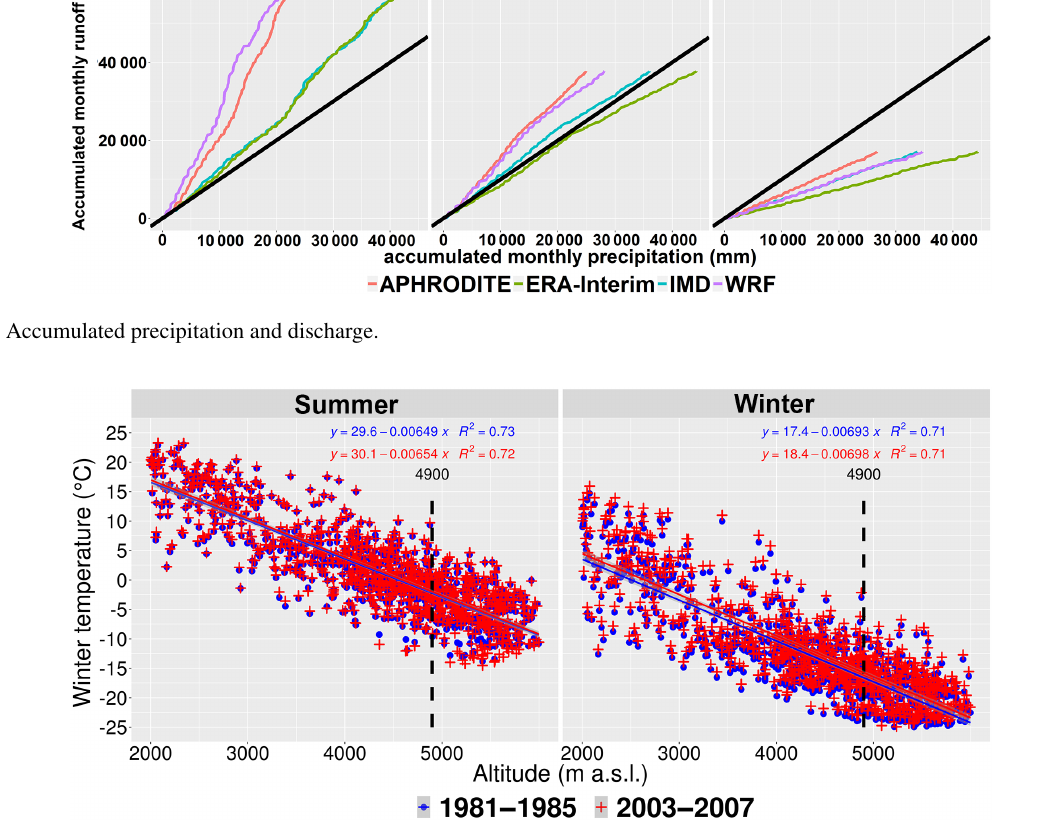
Figure 14. Mean temperature and its regression lines for the periods of 1981–1985 and 2003–2007 by the WRF